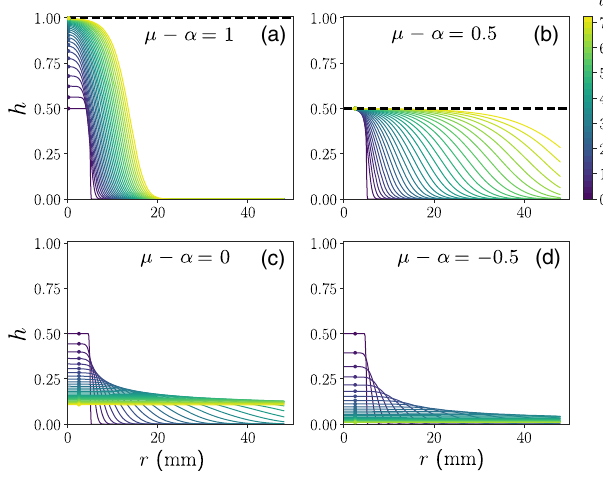
FIG. 9. Numerical solution of Eq. (11) for h ð r ; t Þ =h 0 at different values of μ − α and equal time intervals. The radial ffiffiffiffiffiffiffiffiffiffiffi p D = μ coordinate r is measured in units of , the width of the h Fisher wave in the absence of a dilational flow. The colored dots correspond to the prediction of h as a function of time from Eq. (16) and show good agreement between the theoretical prediction and simulation. (a) For α ¼ 0 , the colony height increases to h=h 0 ¼ 1 , and the front propagates radially with a ffiffiffiffiffiffiffiffiffi p 2 μ D constant velocity v with μ ¼ 1 . (b) When α < μ , the F ¼ h colony front propagation velocity increases exponentially with time, and the colony height decreases to h (cid:3) ¼ h 0 ð 1 − α = μ Þ < h 0 . (c) When α ¼ μ , the dilational flow is strong enough to decrease the colony height below one cell size and h ð t Þ goes to zero logarithmically with radius. (d) For α > μ , the colony thins exponentially fast, potentially signaling that holes open during its early exponential growth; these holes may be responsible for the highly fragmented colonies at later